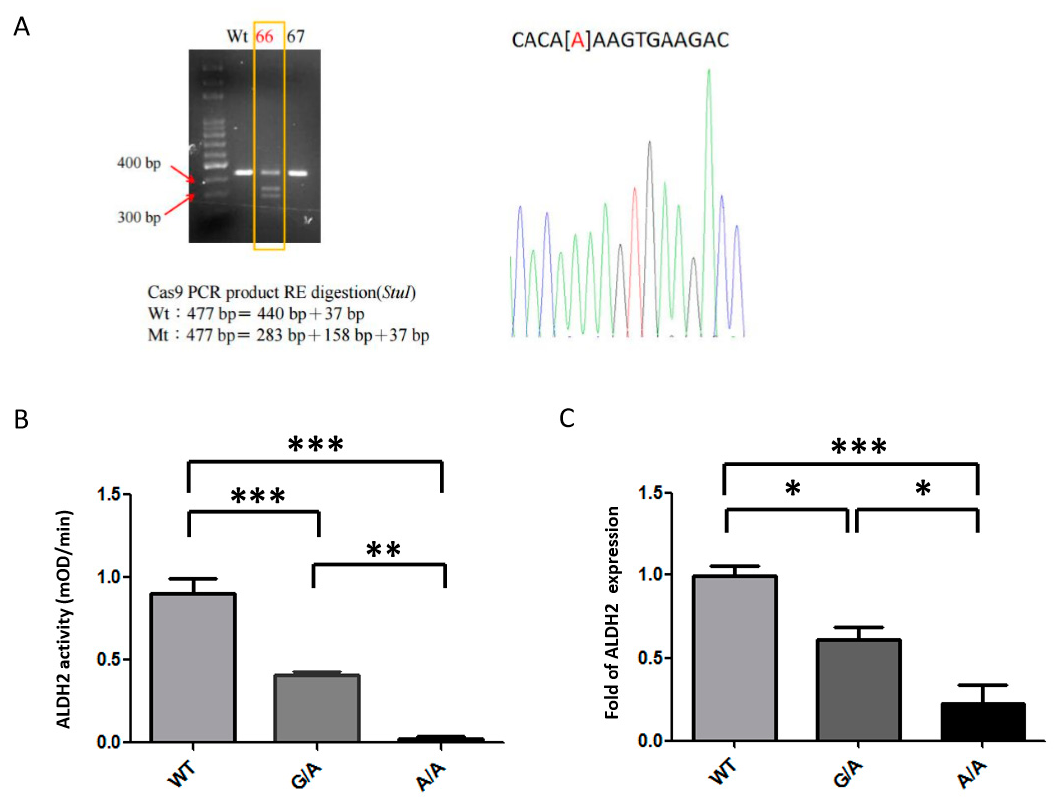
Figure 1. Genotyping and efficacy of Aldehyde dehydrogenase 2*2 knock-in ( ALDH2*2 KI) mice. ( A ) Founder (lane marked by the box) mice containing the KI allele were confirmed by sub-cloning and direct sequencing analysis. [A], G-to-A substitution ( B ) Decreased ALDH2 enzymatic activities in the livers of the ALDH2*2 KI mice. ( C ) Decreased ALDH2 protein expression in the heart tissues of the ALDH2*2 KI mice. WT, wild-type; Mt, mutant; RE, restriction enzyme; * p < 0.05, ** p < 0.01, *** p < 0.001.